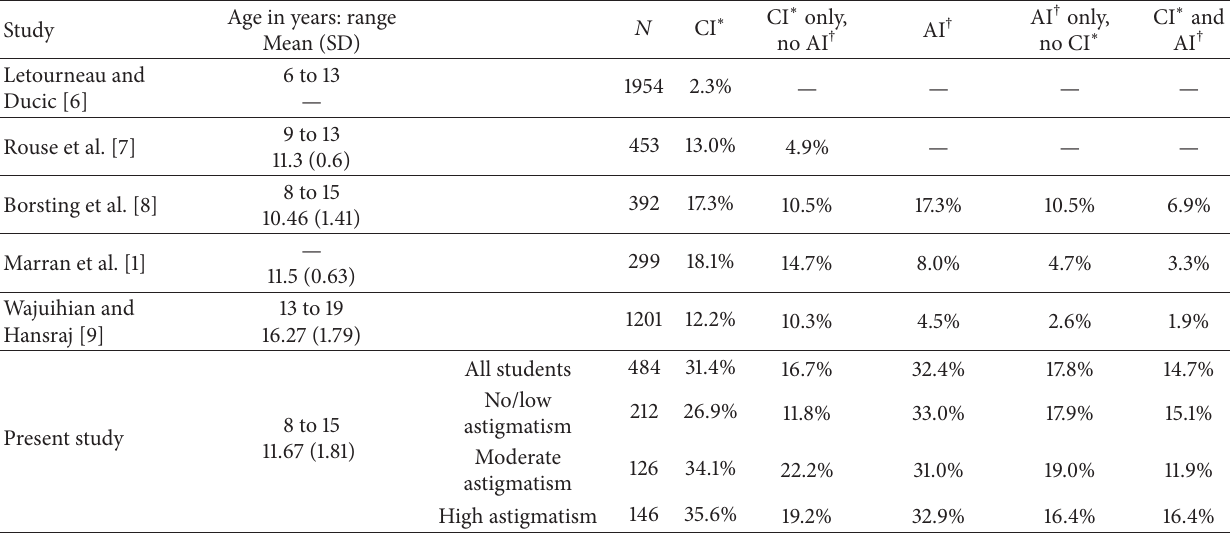
Table1:Rateofconvergenceinsufficiency(“common”(2clinicalsigns)or“classic”/clinical(3clinicalsigns))andaccommodativeinsufficiency (AI) in school-based study samples.